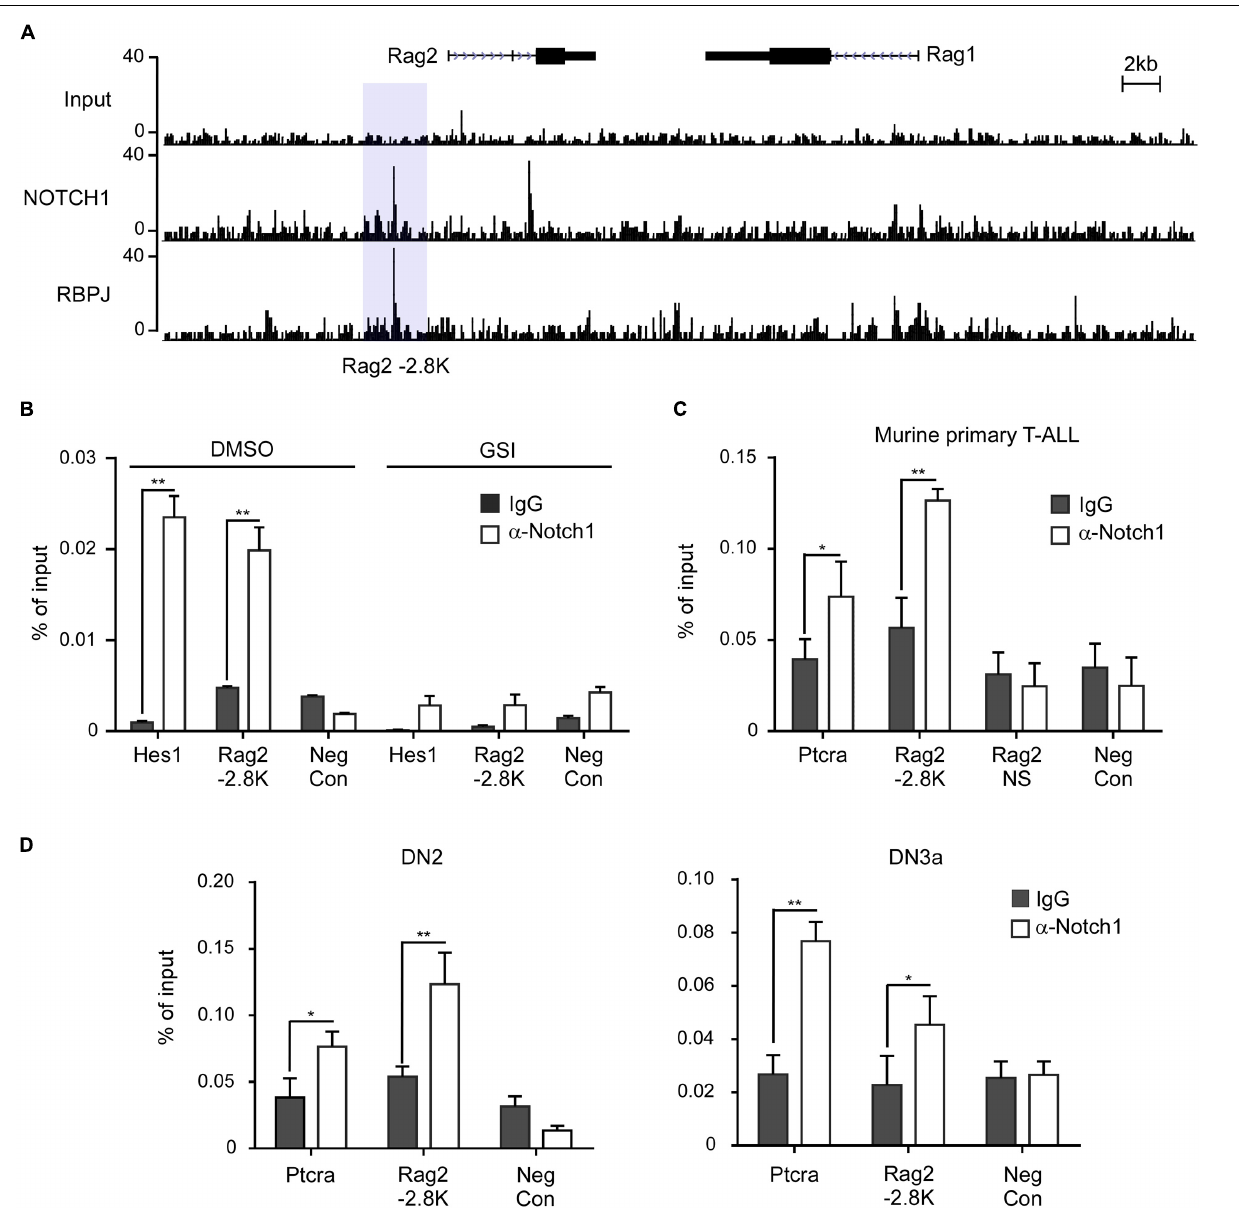
FIGURE 2 | Notch1 directly binds the Rag 1/2 locus in T-ALL cells and T-cell progenitors. (A) Analysis of the Rag2 locus in the ChIP-seq data (GSE 29600). The binding signals of Notch1 and RBPJ on the -2.8 kb site upstream of the Rag2 gene are highlighted in light gray. (B–D) Chromatin immunoprecipitation (ChIP) was performed on cross-linked fragmented DNAs prepared from T6E cells treated with DMSO or 1 µ M JC-18 for 24 h (B) , murine primary T-ALL samples (C) , or murine DN2 and DN3a cells (D) . Eluted DNAs were then analyzed by qPCR using primers flanking the -2.8 kb site. The amount of DNA amplified from immunoprecipitated DNAs was normalized to that amplified from input DNA. Each sample was prepared from at least two independent experiments and run in triplicates. Rag2 NS, non-specific sequence in Rag2 locus; Neg Con, non-specific sequence in the Nanog gene used as the negative control. ** p < 0.01 and * p <